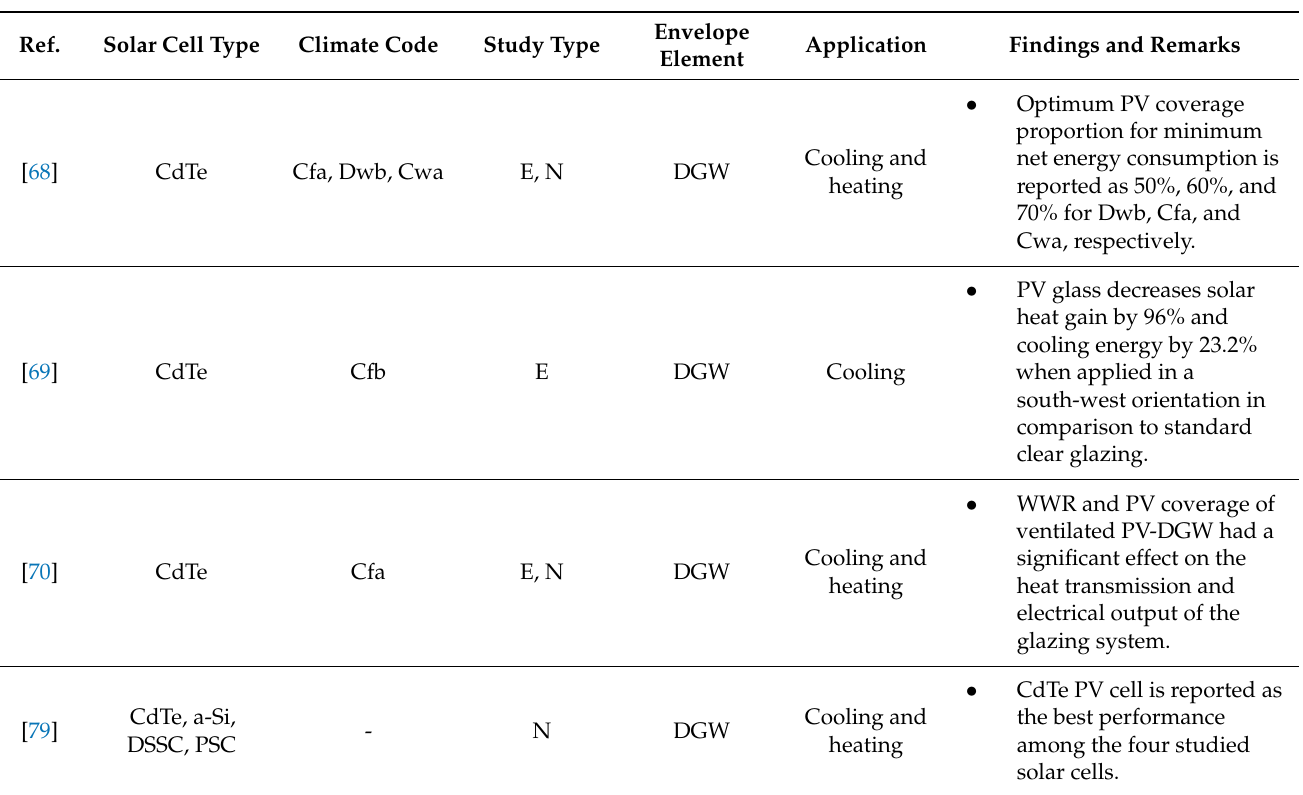
Figure 22. Proposed PV-incorporated DGU system by Tang et al. [64].